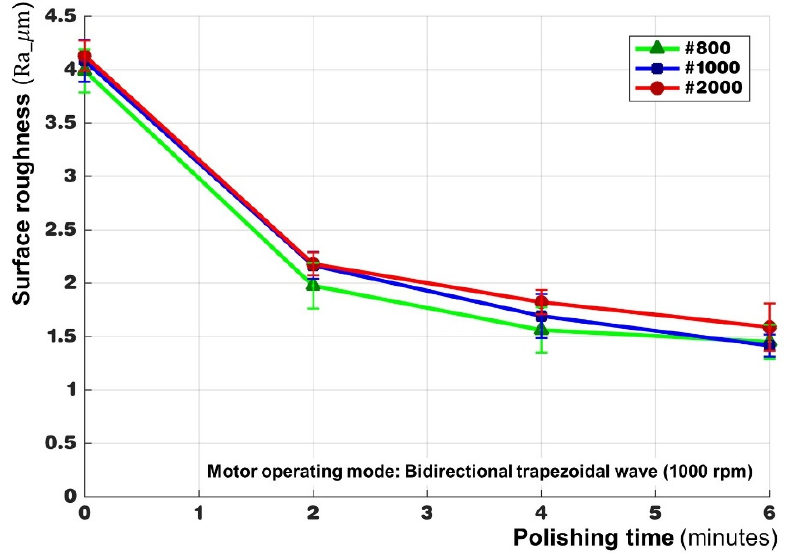
Figure 6. Comparison chart of average material removal weight and polishing time of three motor operating modes.